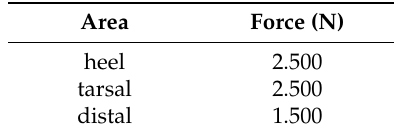
Table 2. Impact forces transmitted to the foot of the prosthesis in a gait